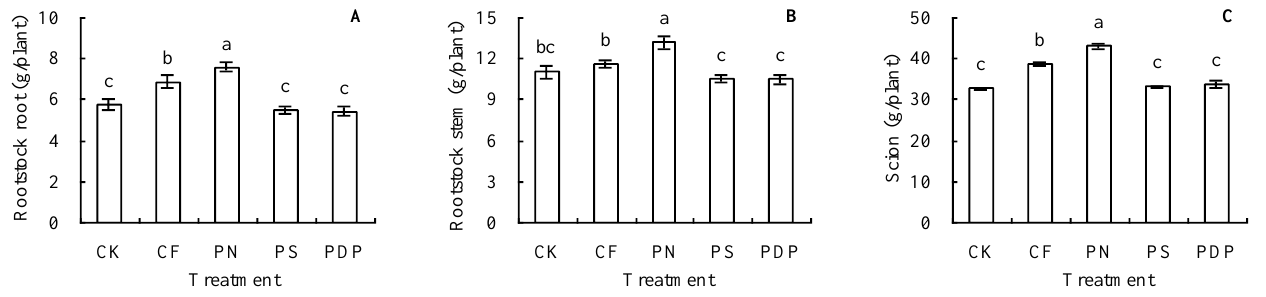
Figure 1. Biomass (dry weight) of grapevine. ( A ) Rootstock root biomass; ( B ) rootstock stem biomass; ( C ) scion biomass. Different lowercase letters indicate significant differences among the treatments (Duncan’s Multiple Range Test, p < 0.05). CK—control; CF—complex fertilizer; PN—potassium nitrate; PS—potassium sulfate; PDP—potassium dihydrogen phosphate.